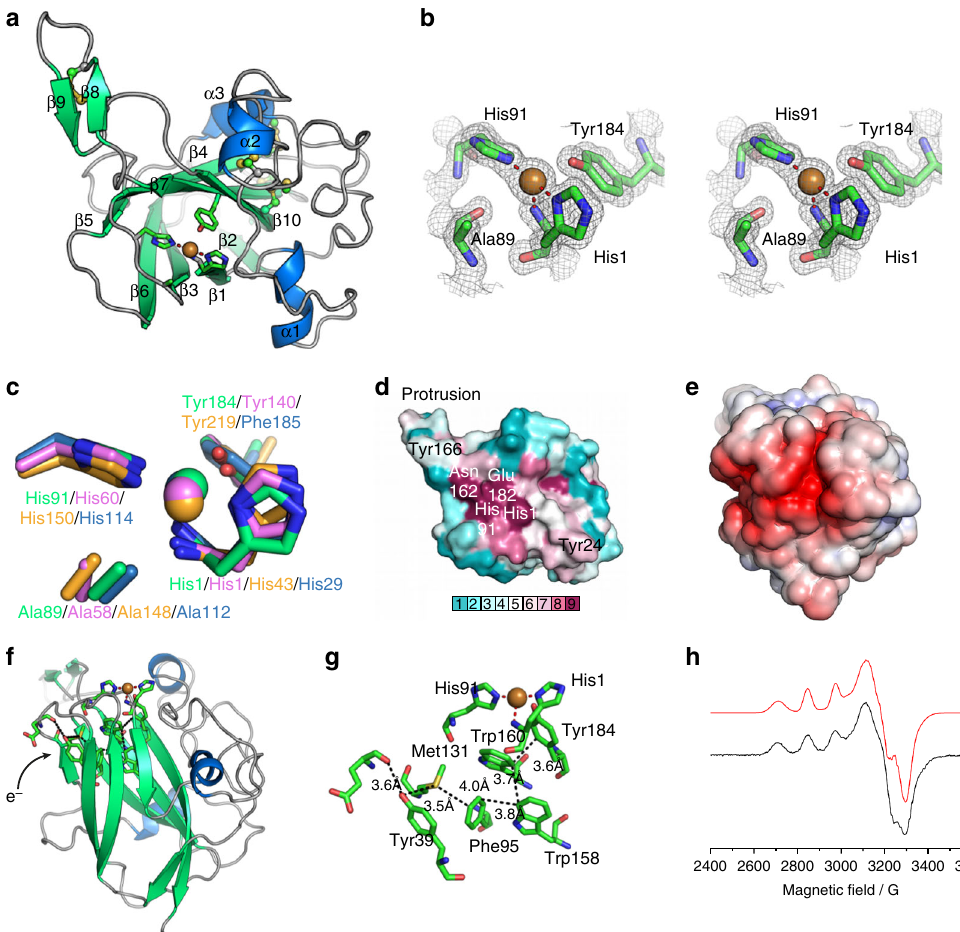
Fig. 4 Structural and spectroscopic characterization of Td AA15A. a The overall structure of Td AA15A is shown colored by secondary structure. The protrusion formed by strands β 8 and β 9 is clearly shown extending the surface surrounding the active site. Disul fi de bonds are shown in ball and stick with sulfur atoms colored yellow. b Stereo view of the electron density observed at the copper active site of Td AA15A (2mFo-Fc map contoured at 1 σ ). The histidine brace coordination of the copper, which is in the Cu(I) state due to photoreduction in the X-ray beam, is shown by red dashed lines. The copper ion is shown as a golden colored sphere. c The active site of Td AA15A (green) was superposed with equivalent residues from Ao AA11 3 (pdb 4mai, violet, a C1 speci fi c chitin active LPMO), Sc LPMO10B 68 (pdb 4oy6, orange, an LPMO with both C1 and C4 oxidizing activity on cellulose, and C1 oxidizing activity on chitin), and Ef AA10 69 (pdb 4als, blue, a chitin active C1 speci fi c LPMO) giving rmsds of 0.71 Å over 37 atoms, 1.13 Å over 37 atoms, and 0.59 Å over 37 atoms, respectively. The axial alanine in the chitin active Ef AA10 superposes closely with Ala 89 from Td AA15A while the equivalent alanines in Ao AA11 and Sc LPMO10B do not occupy the same position. d Sequence conservation analysis (ConSurf) of Td AA15A looking down on the active site. The surface is colored by ConSurf score according to the indicated scoring scheme. The conserved residues in the active site are labeled along with the protrusion and surface exposed tyrosines (Tyr166 and Tyr24). e Electrostatic surface potential of Td AA15A showing the large negatively charged patch (red) present on the protein surface that could be a docking site for a protein partner. The APBS plugin for PyMol was used to calculate and visualize the surface electrostatic potential at ±5 KBT/e. f Cartoon representation of Td AA15A in the same orientation as the electrostatic surface potential diagram in e . The possible entry point for electrons is indicated and the potential electron transferring residues are shown as sticks colored by atom type. g Potential electron wire through the protein core. The shortest distances between atoms in each residue are shown by black dashed lines. h Continuous wave X-band EPR spectrum (9.3 GHz, 160 K) with simulation (red) of Td AA15A in sodium phosphate buffer pH 7 and 10% v/v glycerol. Simulations were obtained with 15% of species 1, see Supplementary Table 3 for more